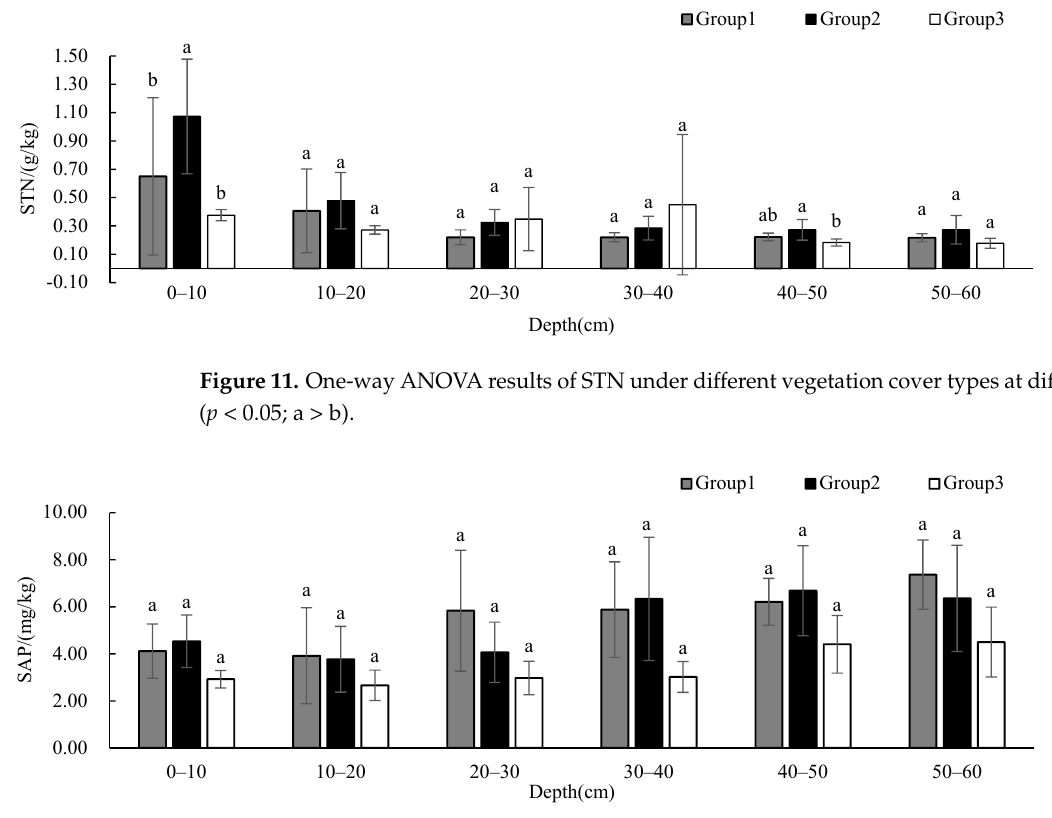
Figure 12. One-way ANOVA results of SAP under different vegetation cover types at different depths ( p < 0.05).